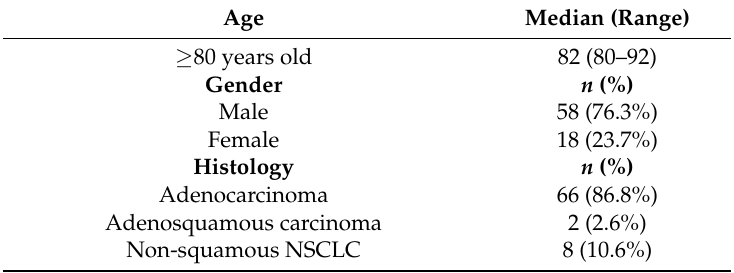
Table 1. Clinicopathological characteristics of patients included in the